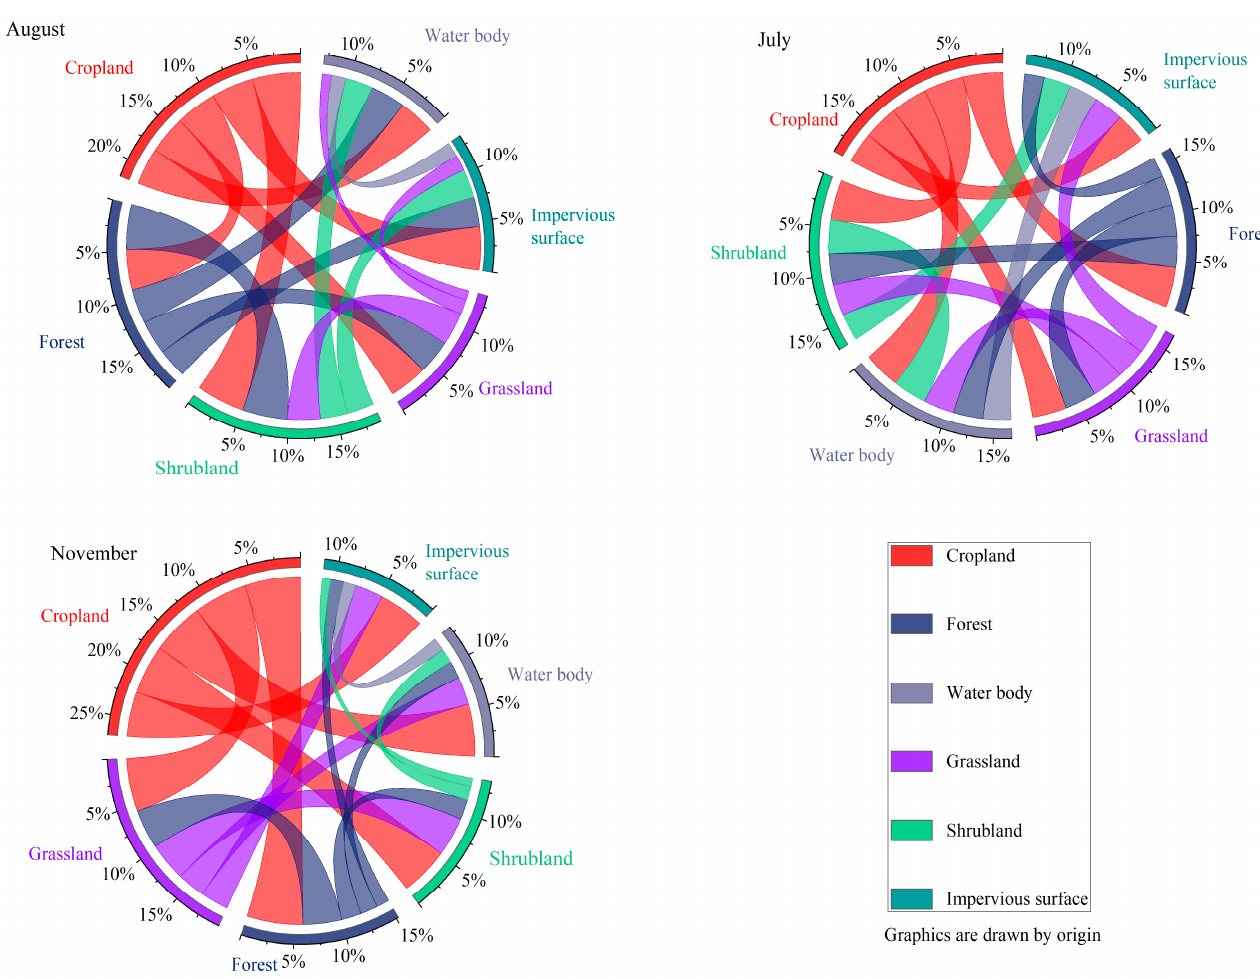
Figure 10. Interactive factor analysis results by type of landscape and water quality characteristics in the Maotiao River Basin (Gizhou province, SW China) in 2020.